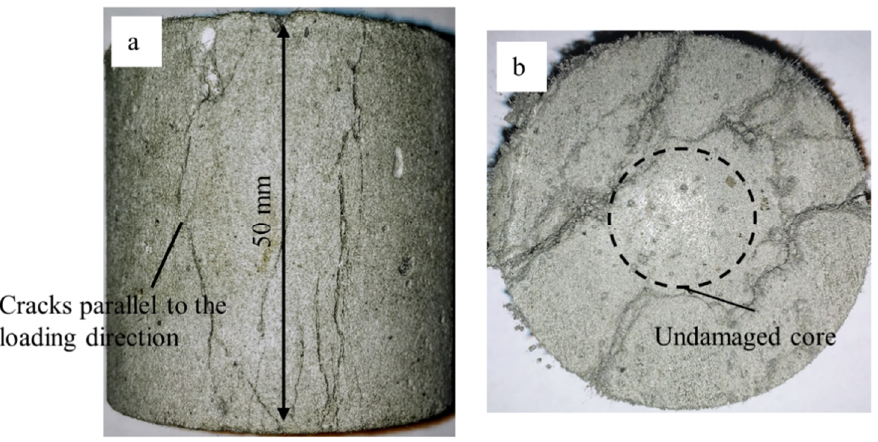
Figure 8. Failure mode in a M1-6PE specimen tested in the SHPB: ( a ) cracks parallel to the loading direction, ( b ) middle cross-section of the specimen.